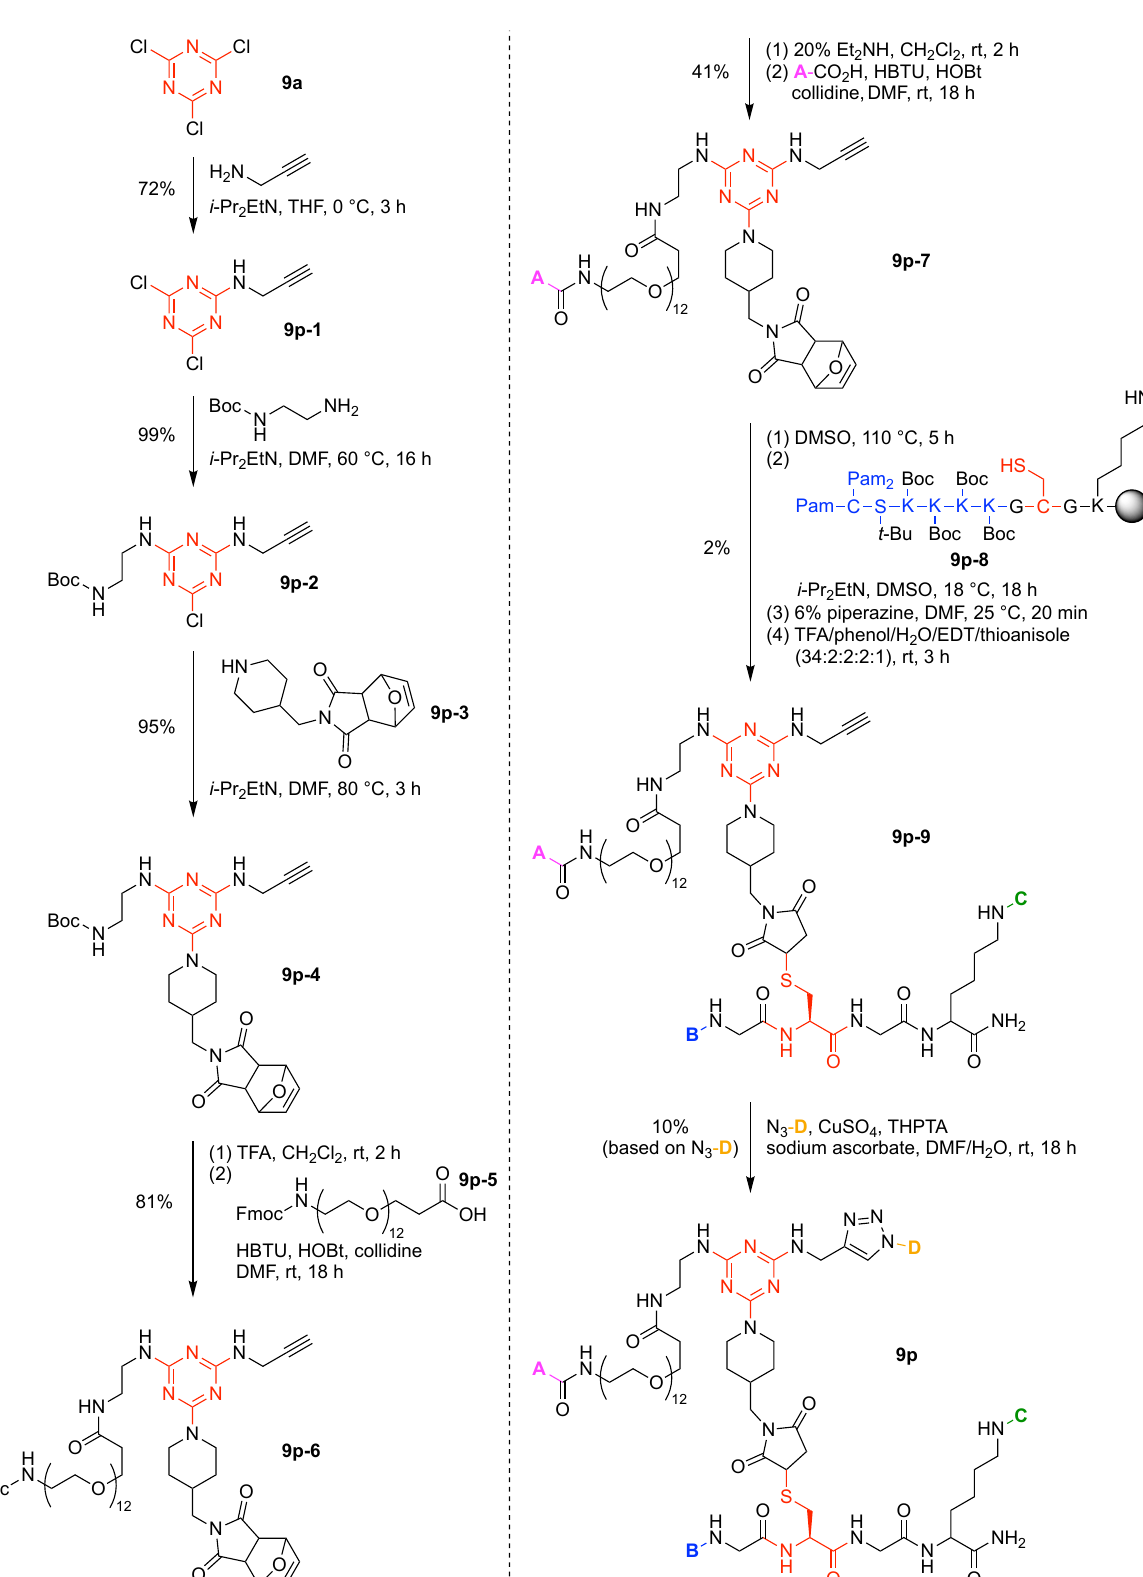
Figure 40. Synthesis of a TLR triagonist connected to a fluorophore via a triazine hub. We explored the formation of molecular scaffolds upon enzymatic action under physiological conditions. Such scaffolds can be utilized for diverse applications in the life